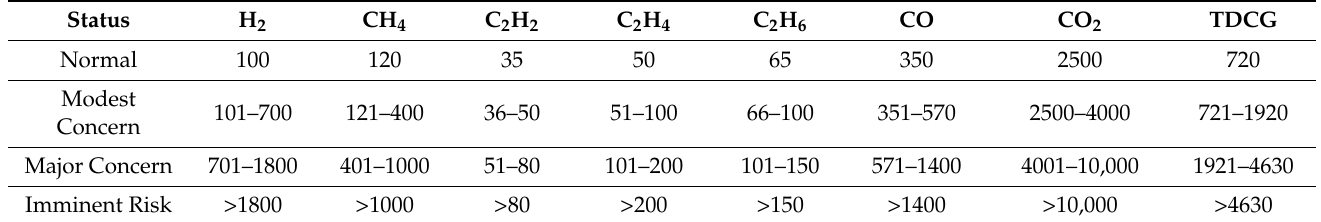
Table 1. Dissolved key gas concentration limits (ppm).